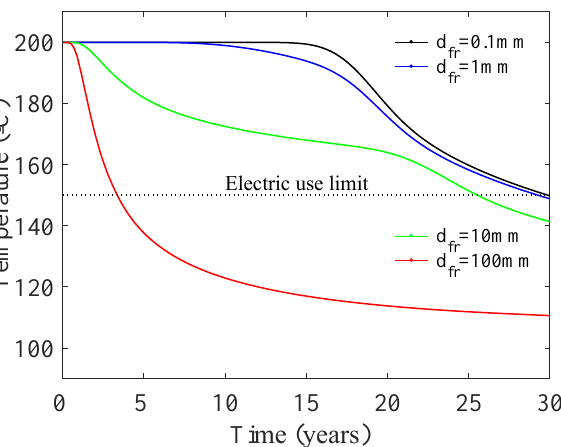
Figure 7. Averaged temperature at the extraction well for different fault apertures. The dashed line shows the usual threshold of water temperature to produce electric energy. This threshold is reached sooner or later depending on the fault